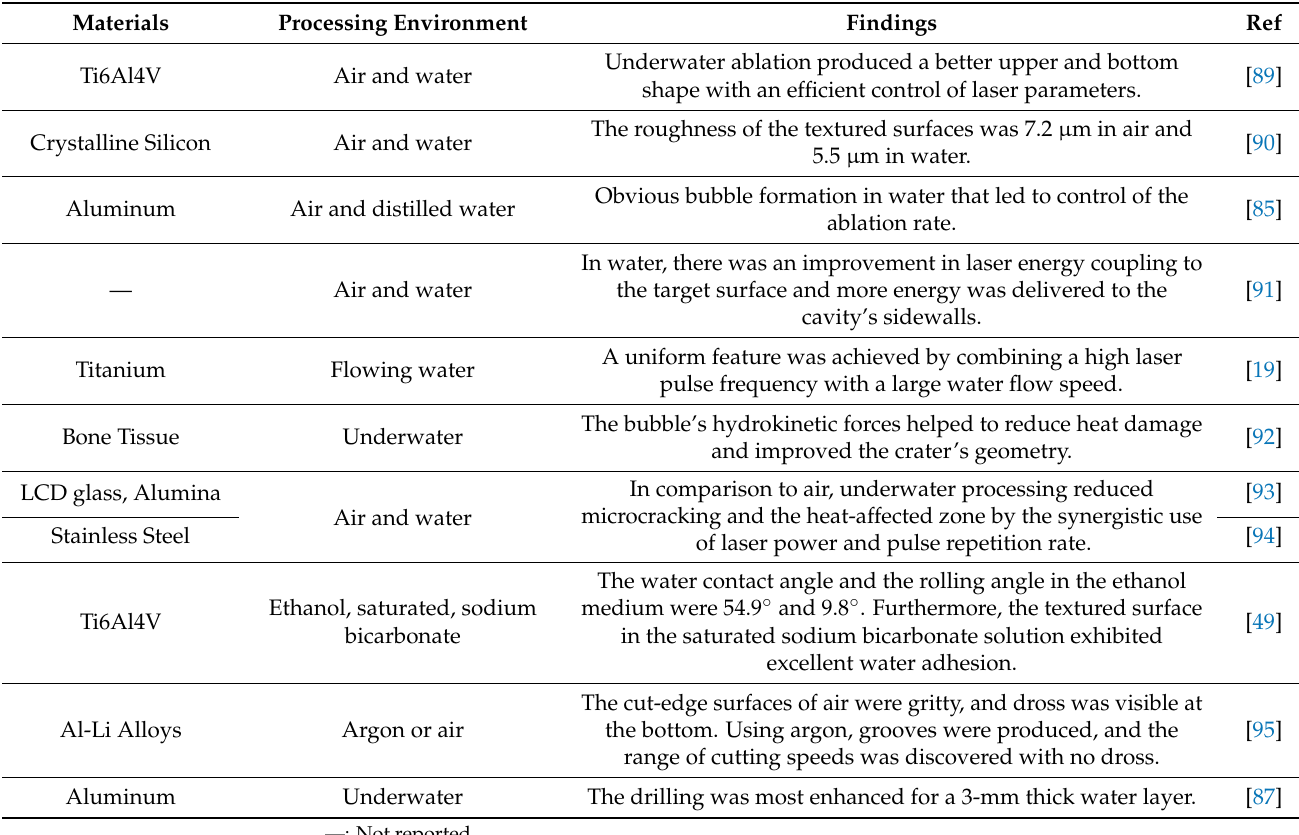
Table 3. Some studies on water ablation